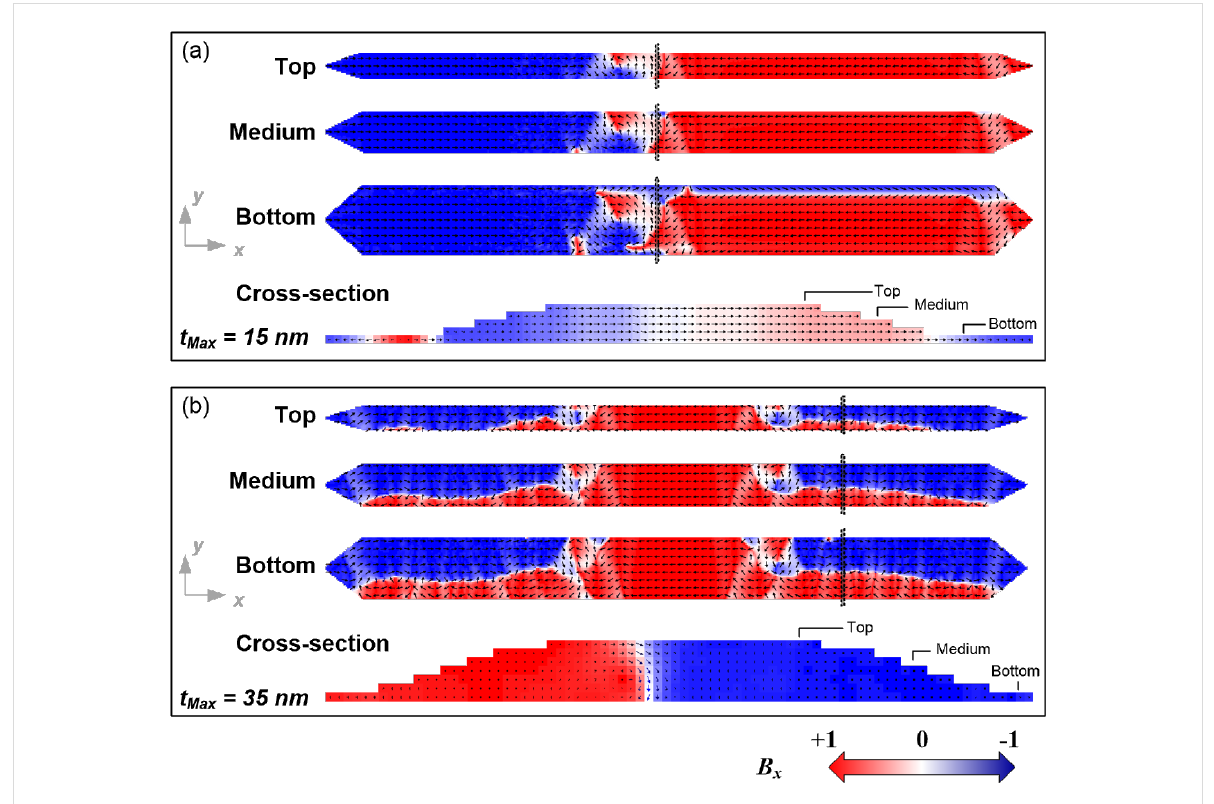
Figure 9: Magnetization vector-color maps extracted from the simulations for 250 nm wide Fe nanowires with bell-shaped profile (case II) and nominal thickness of (a) 10 nm and (b) 20 nm. The areas marked with black lines in the x , y plane representations have been chosen for the represen- tation in the y , z plane